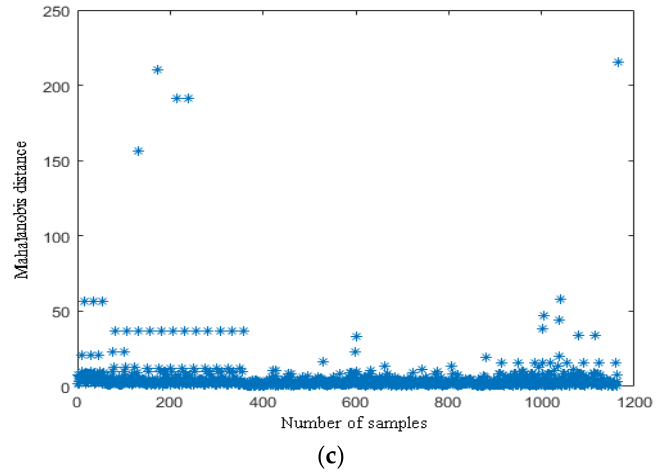
Figure 2. The (MD) distribution points of the ripe fruit ( a ), half-ripe fruit ( b ), and unripe fruit ( c ). The thresholds of the ripe fruit, half-ripe fruit, and unripe fruit were 14.9441, 57.5544, and 46.4618, respectively. The samples of the ripe fruit, half-ripe fruit, and unripe fruit were eliminated when the T values were more than 14.9441, 57.5544, and 46.4618, respectively. The amounts of eliminated abnormal samples of the ripe fruit, half-ripe fruit, and unripe fruit were 28, 1, and 10, respectively. For example, the eliminated abnormal samples of the three fruit are shown in Figure 3. As shown in Figure 3a, there was one ripe fruit in this figure and the T value of this ripe fruit was 17.2988. The T value of this ripe fruit was more than 14.9441, so that this ripe fruit was an abnormal sample. It was clearly observed that this ripe fruit was not conducive to the subsequent establishment of the model due to the effect of illumination. As shown in Figure 3b, the fruit on the far left was the half-ripe fruit in this figure and the T value of this half-ripe fruit was 407.4555. The T value of this half-ripe fruit was more than 57.5544, so that this half-ripe fruit was an abnormal sample. It was clearly observed that this half-ripe fruit was not conducive to the subsequent establishment of the model due to the fuzziness. As shown in Figure 3c, the fruit on the far left was the unripe fruit in this figure and the T value of this unripe fruit was 59.2474. The T value of this unripe fruit was more than 46.4618, so that this unripe fruit was an abnormal sample. It was clearly observed that this unripe fruit was not conducive to the subsequent establishment of the model due to the effect of shadow. Therefore, the amounts of the ripe fruit, half-ripe fruit, and unripe fruit used to establish the model were 1800, 555, and 1154, respectively.